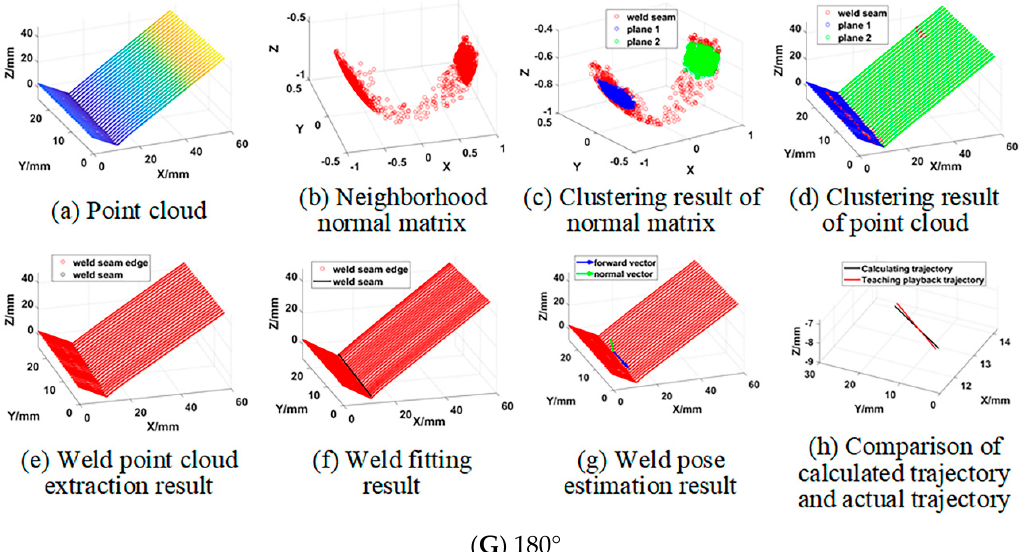
Figure 12. 3D zigzag-line welding seam pose information online extraction results.